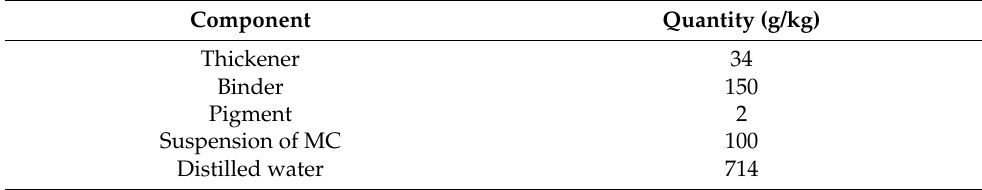
Table 1. The recipe of the printing paste.